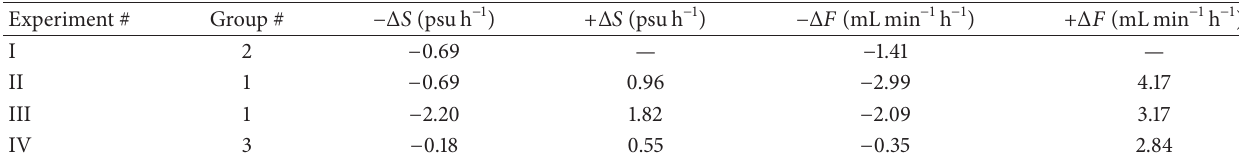
Table 2: Mytilus edulis . Variation in filtration rates ( Δ𝐹 ) of mussels at different salinity changing rates ( Δ𝑆 ). Experiments were performed